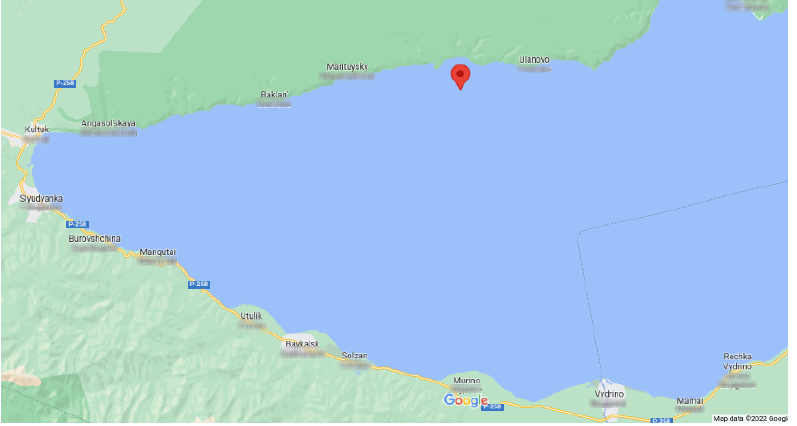
Figure 1. Google Map screen shot of the Baikal-GVD location and its position relative to the lake shore in the